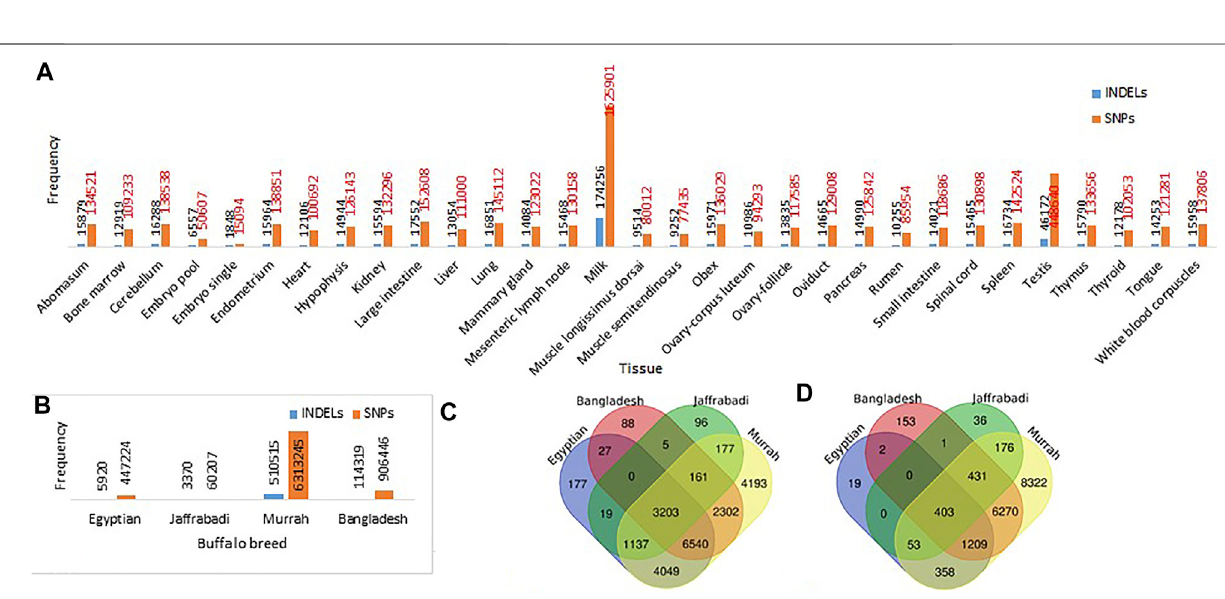
Frontiers in Genetics |